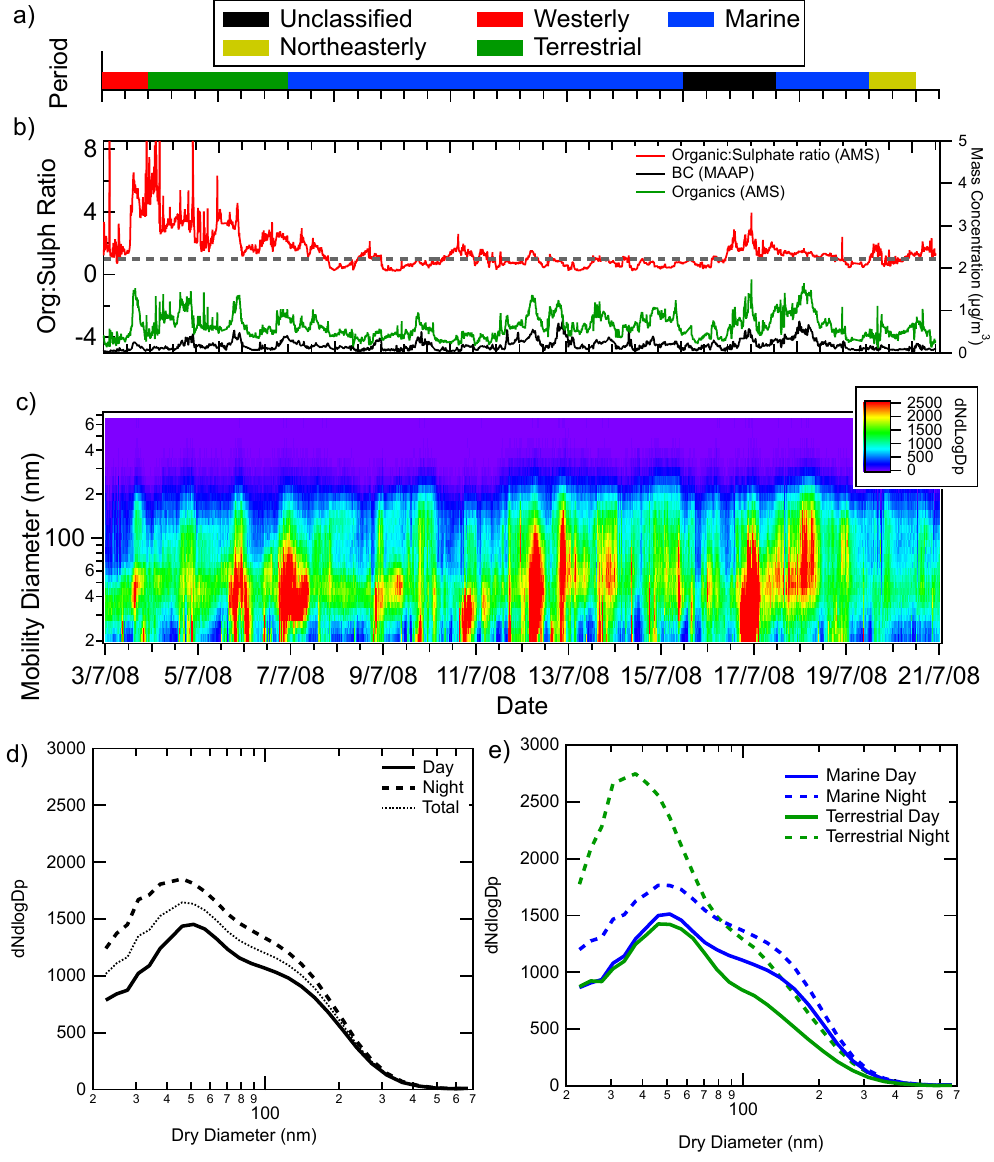
Fig. 1. (a) the sectorisation of the OP3-III campaign, for the time series of the aerosol instrumentation used in this paper. (b) the total organic:sulphate ratio, constituent organic mass as measured by the HR-AMS and BC as measured by MAAP. (c) the DMPS number-size distribution for the measurement period. The periods are defined as 0 Unclassified, 1 Westerly, 2 Coastal, 3 Marine, 4 Northeasterly and 5 Terrestrial. (d) Day and Night averages and (e) Sectorised averages of the DMPS